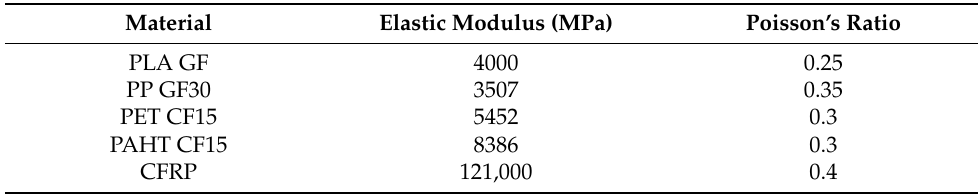
Table 4. Material characteristics used in FEA simulation.